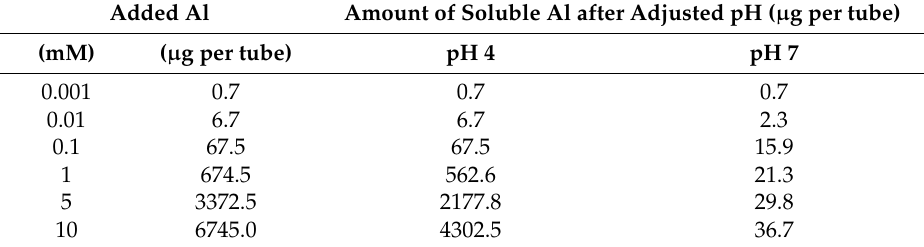
Table 2. Soluble Al in solution (no biochar present) at different concentrations after adjustment to pH 4 and pH 7. Added Al